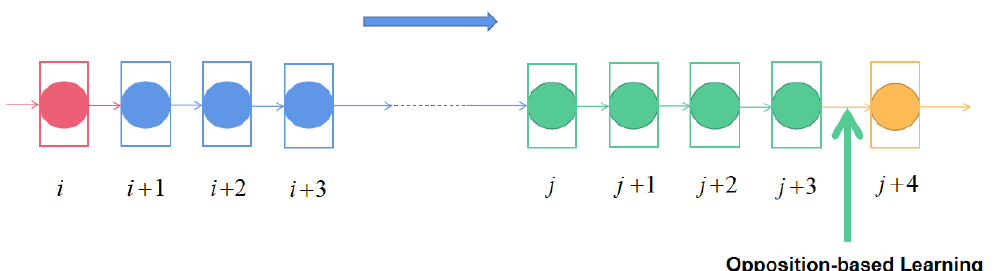
Figure 2. Opposition-based learning with sliding window